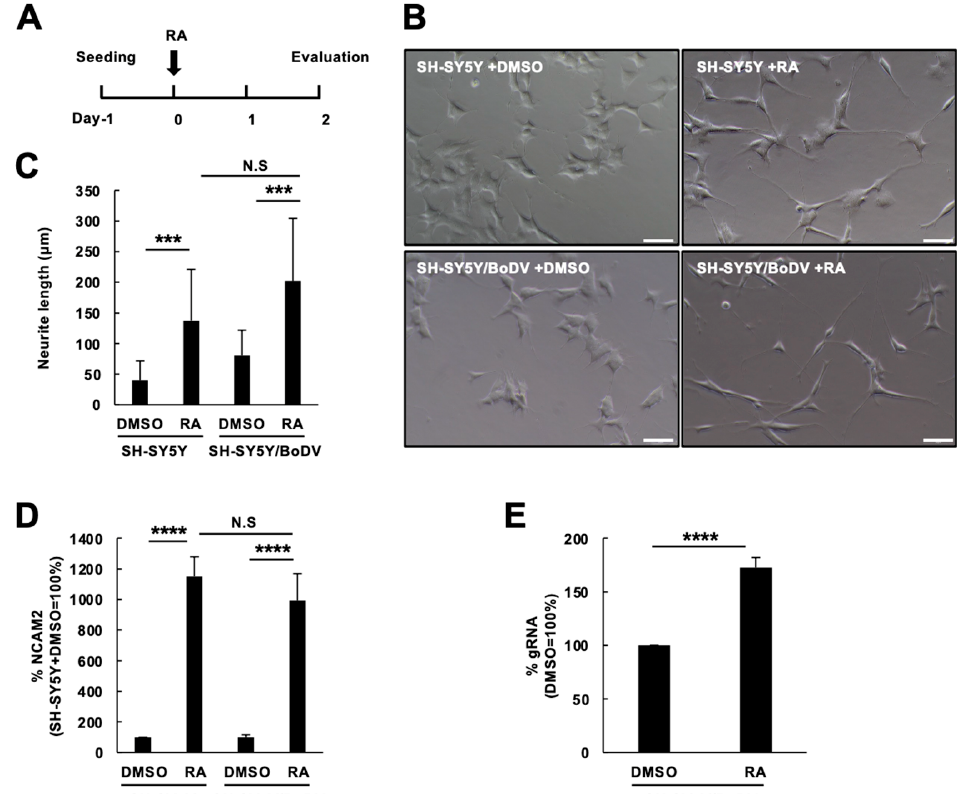
Figure 1. Neuronal differentiation of BoDV-1-infected SH-SY5Y cells. ( A ) Differentiation protocol of SH-SY5Y cells used in this study. SH-SY5Y cells were differentiated with 10 µ M retinoic acid (RA) for 2 days. ( B – D ) Neuronal differentiation of BoDV-1-infected and uninfected SH-SY5Y cells. Neuronal differentiation was evaluated with the cell morphological changes ( B ), the total length of neurites in a cell ( C ), and the NCAM2 gene expression ( D ). ( E ) BoDV-1 infection in differentiated (RA) and undifferentiated (DMSO) SH-SY5Y/BoDV cells. Bars, 30 µ m. We calculated the expression of each gene using the ∆∆ Ct method. The expression of each gene was normalized with that of the GAPDH gene in each condition. Values are expressed as the mean percentage + standard error of the mean (SEM) of at least three independent experiments. N.S, non-significant; ***, p < 0.005; ****, p < 0.001.